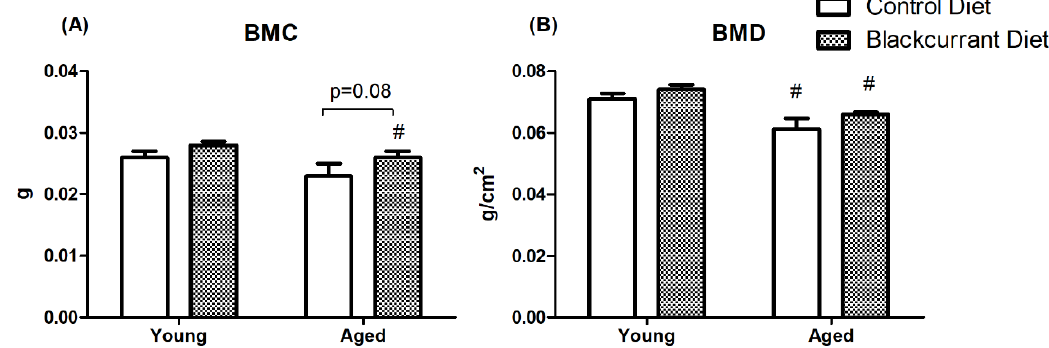
Figure 5. Dual-energy X-ray absorptiometry (DXA) analysis of ( A ) bone mineral content and ( B ) bone mineral density of femurs in young and aged mice consuming a control or blackcurrant (1% w / w ) diet for 4 months. Values are reported as mean ± SEM. Data were analyzed using an independent t -test. Young control ( n = 10), young BC ( n = 10), aged control ( n = 7), and aged BC ( n = 7). # Indicates significant difference by age in mice consuming the same diet. BMC, bone mineral content; BMD, bone mineral